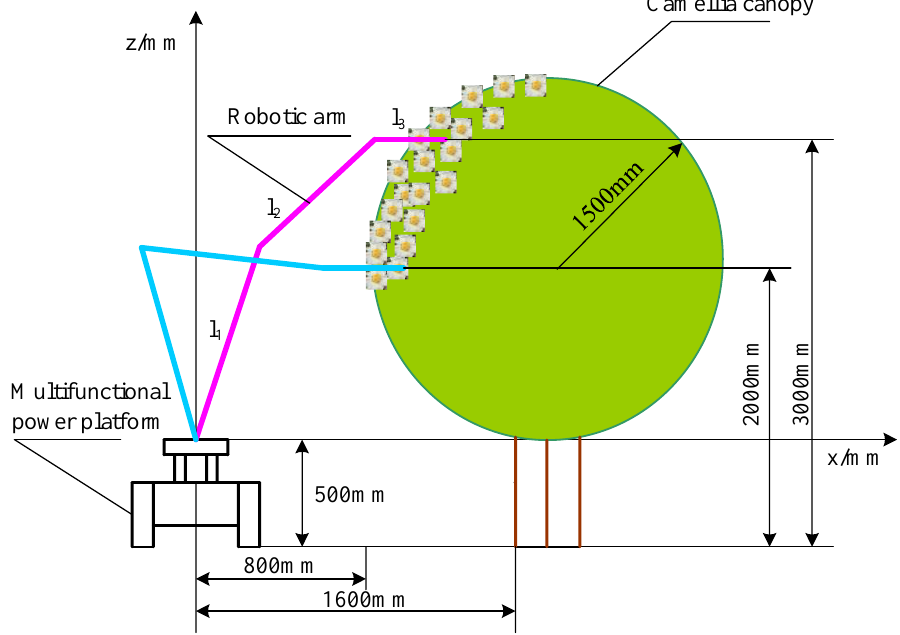
Figure 3. View of the pollen-picking robot and the target picking area.